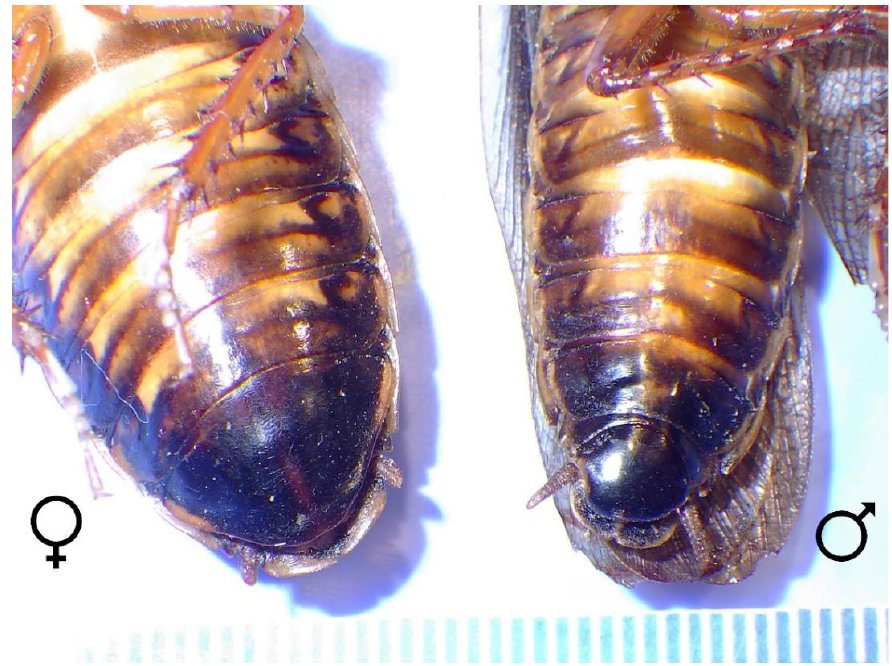
Figure 2. Dubia roaches ( Blaptica dubia ) image indicating sexual dimorphism in the species. The caudal most visible sternite in females (animal on the left ) is larger & wider than in males (animal on the right ), with males appearing to have an extra visible sternite.